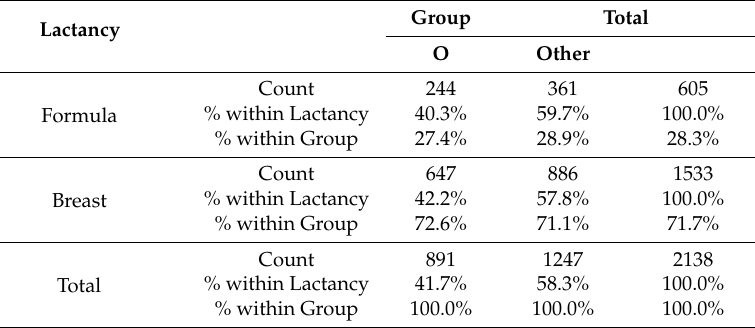
Table 4. Crosstab lactancy vs. blood